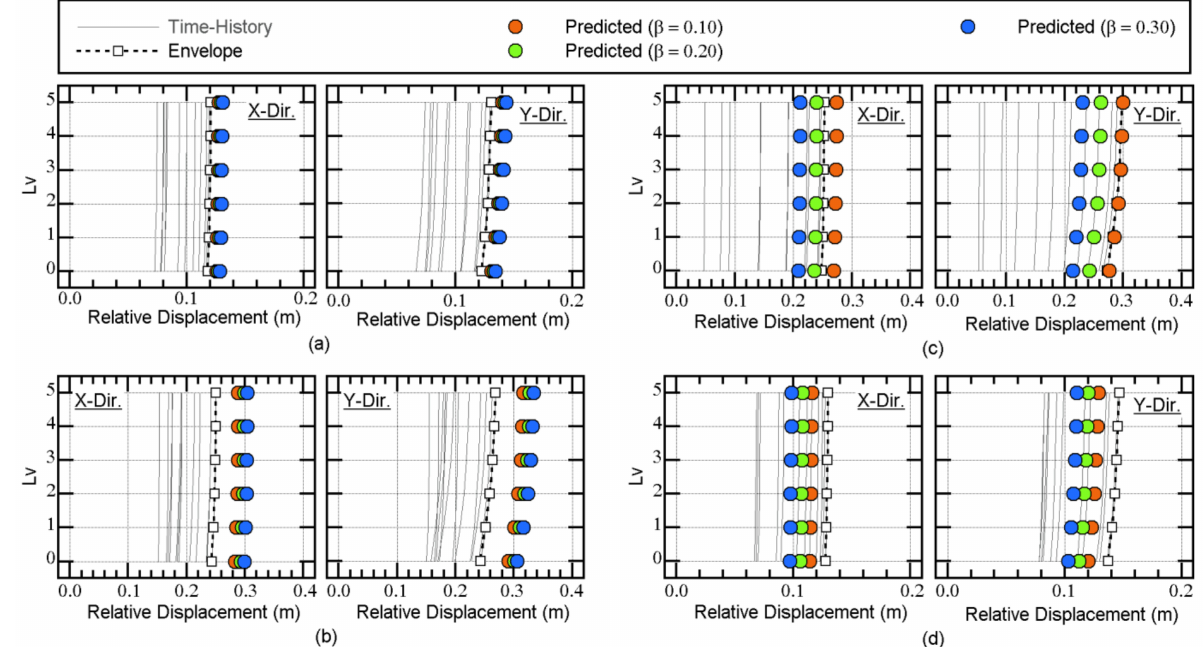
Figure 23. Comparison of the horizontal distributions of the peak displacement at level 0 (model: Model-Tf44, ground motion: Art-1 series).